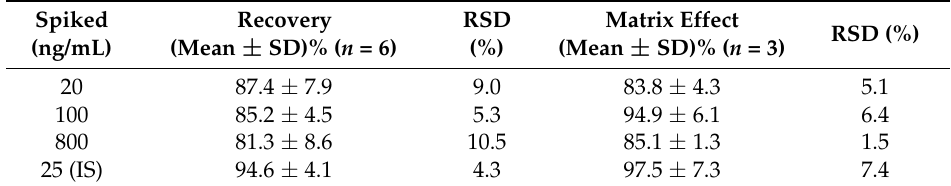
Table 2. Extraction recovery and matrix effect for sodium danshensu and IS in six different sources of beagle dog